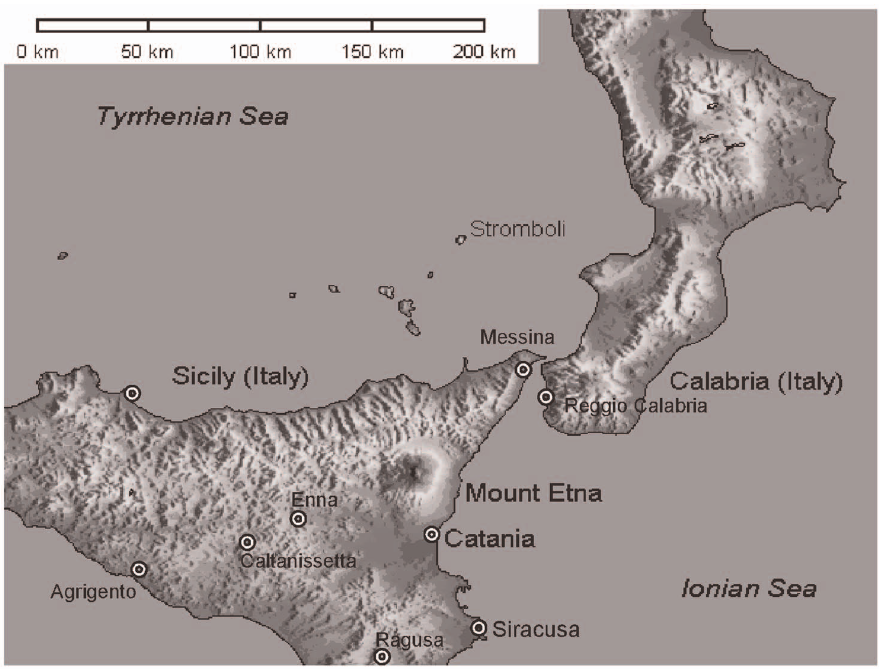
Figure 1. Geographic location of the Catania and Messina provinces. Approximately, 14% of the Catania cohort is represented by HT patients coming from the neighboring provinces of Siracusa (6%), Ragusa (2.5%), Enna (2%), Caltanissetta (2.5%) and Agrigento (0.7%). This compares with approximately 18% of the Messina cohort of HT patients coming from Southern Calabria, particularly from the province of Reggio Calabria. Population in these provinces is approximately 1.1 million (Catania), 660,000 (Messina), 400,000 (Siracusa), 300,000 (Ragusa), 275,000 (Caltanissetta), 175,000 (Enna), 450,000 (Agrigento), and 560,000 (Reggio Calabria).